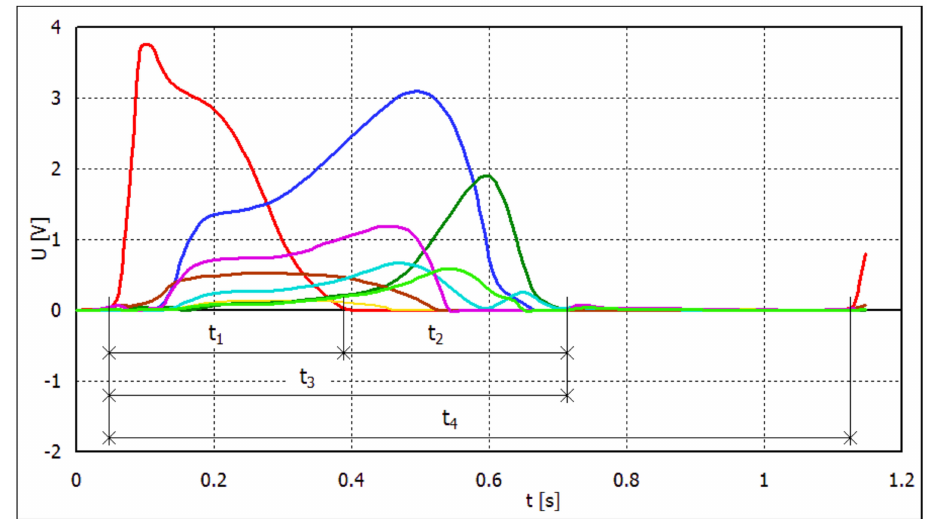
Figure 2. Phases: t 1, t 2, t 3, and t 4 of the step. The amounts of energy generated in the “stride” and “stance” phases are the same; however, because the duration of the “stride” phase is longer ( t 4 > t 3), the corresponding power is